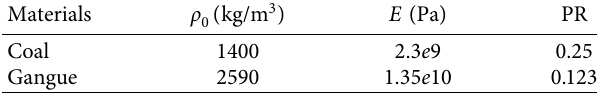
Table 1: Material model parameters for coal and gangue.